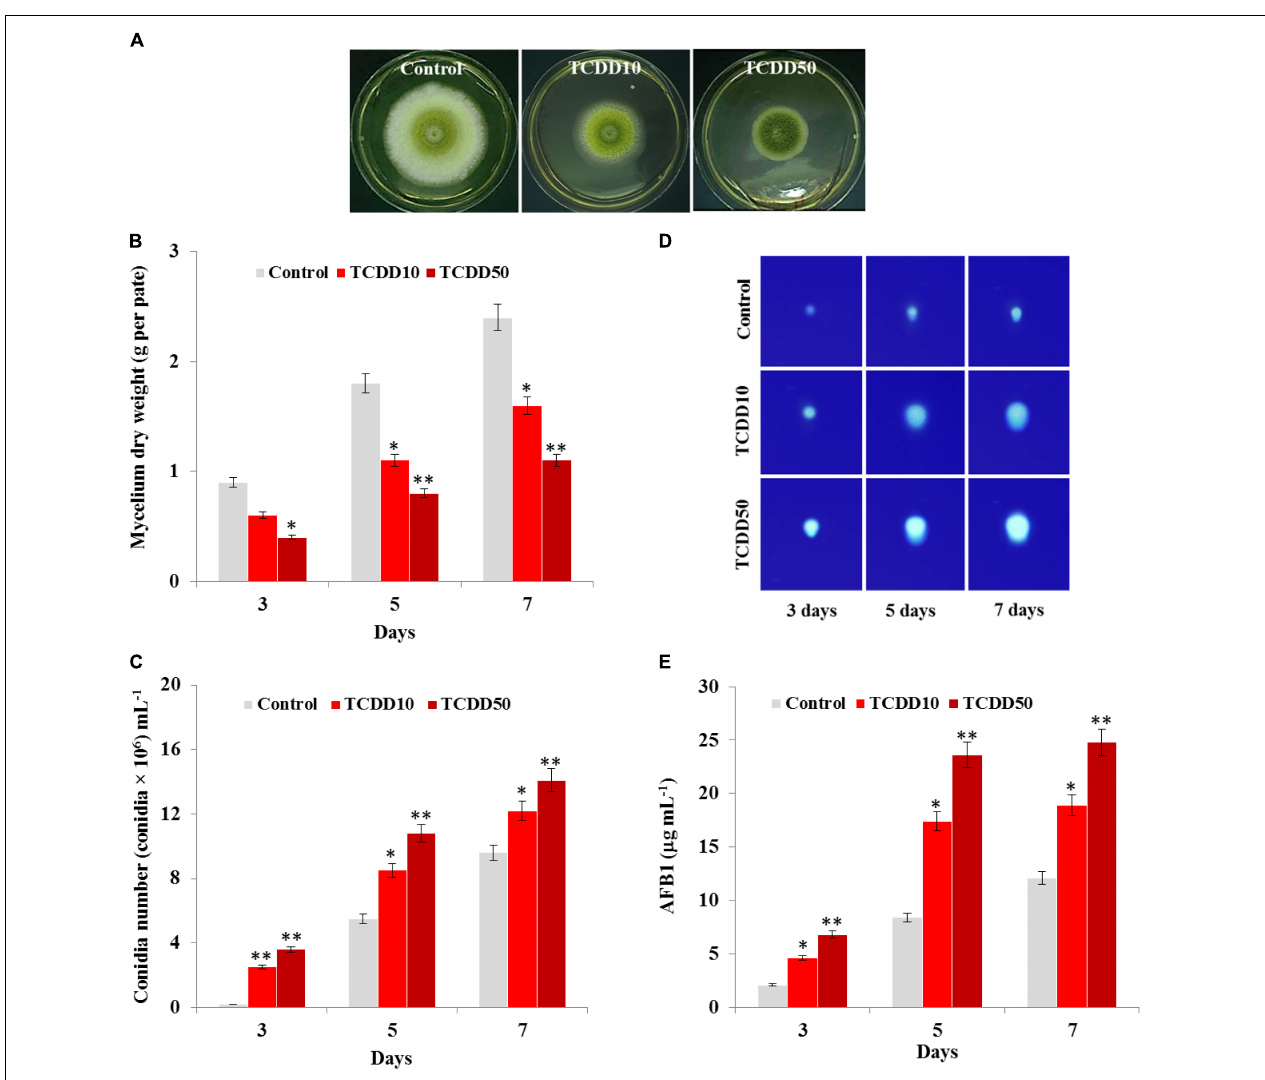
FIGURE 1 | Characteristic of A. flavus TCDD-exposed phenotype. (A) Photographs of 5-day-old cultures of A. flavus on PDA-plates upon the exposure to TCDD at 10 and 50 ng L − 1 that referred as to TCDD10 and TCDD50, respectively, compared with non-exposed fungus control. (B,C) Variation in fungal mycelium dry weight and spore number, respectively, as a function of the exposure to TCDD at both doses. (D) Sections of Thin Layer Chromatography (TLC) plate showing the blue-fluorescent spots under the UV light that correspond to the AFB 1 secreted by the TCDD-exposed fungi compared to control. (E) Quantitative data of AFB 1 as estimated by UV-detector HPLC. All measurements were done in triplicate and the presented data are means ± SD ( n = 3). Difference between treatments and control was significant ( ∗ P < 0.05) or very significant ( ∗∗ P < 0.01) when analyzed by t